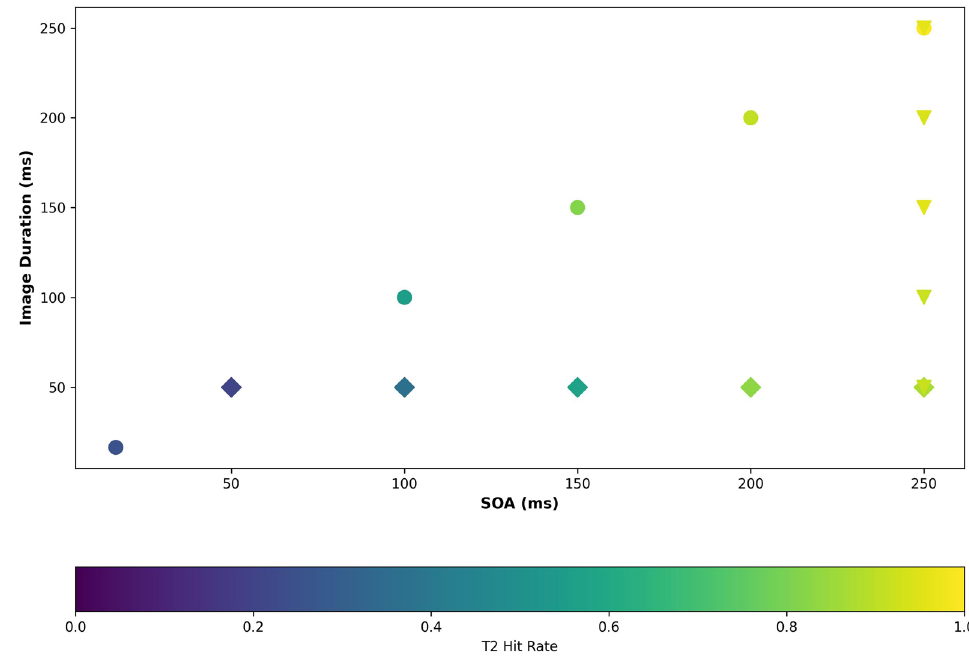
Figure 3. Relationship between presentation rate (SOA), Image Duration (t image ), and T2 (lag 1) Accuracy. Circles represent data from Experiment 1. Diamonds represent data from Experiment 2A. Inverted triangles represent data from Experiment 2B. Presentation rate (SOA), not accumulation of visual information (image duration) defines the lower limit of endogenous boost in attention to lag-1 targets.